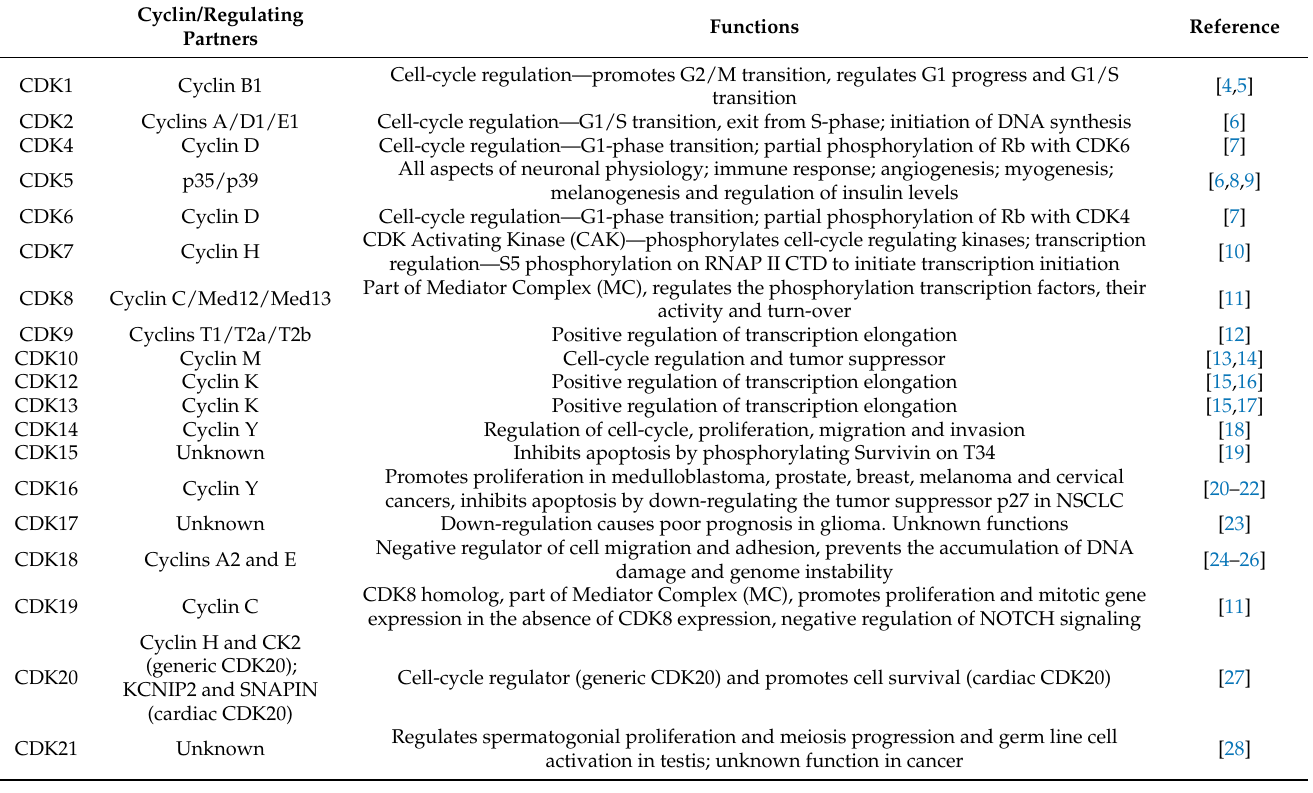
Table 1. The different known members of the CDK family, their regulating cyclin partners (except CDK5) and their general functions. Cyclin/Regulating